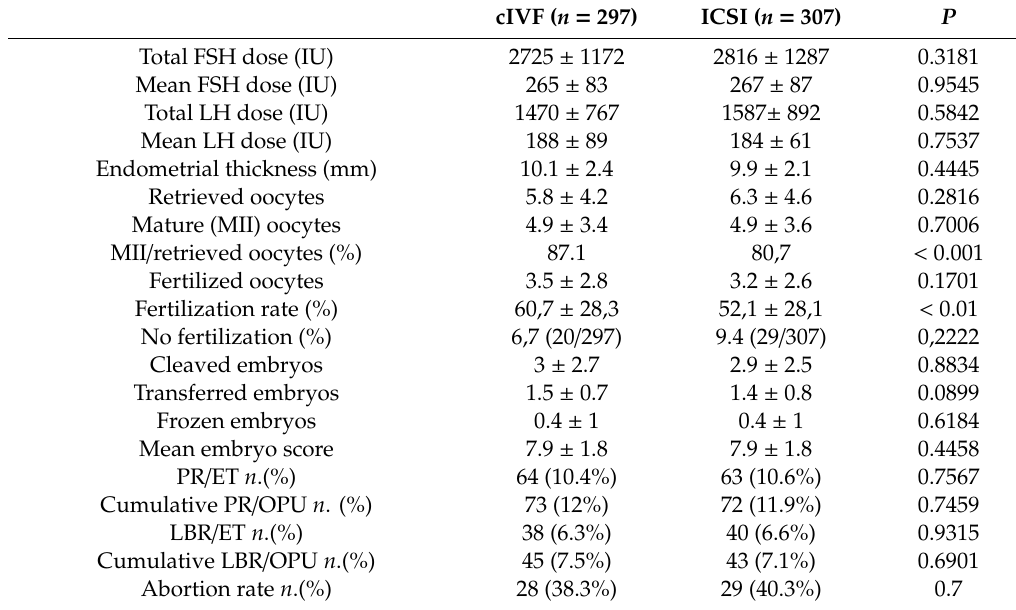
Table 2. Cycle outcome in the two study groups (univariate